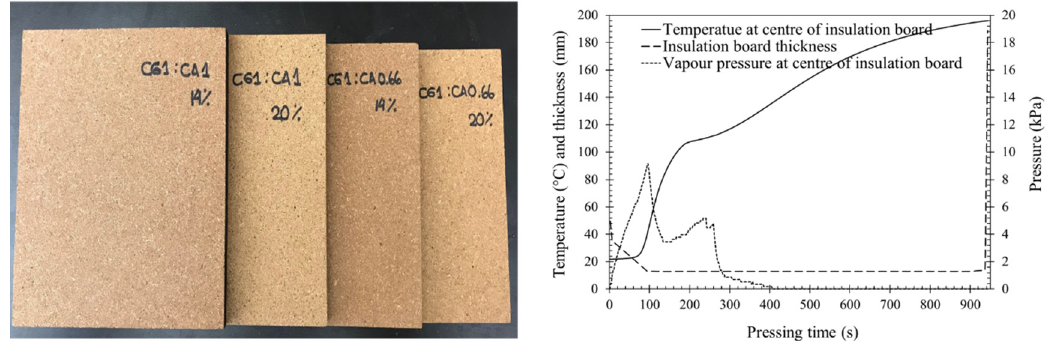
Figure 2. Wood fiber insulation boards and evolution of the temperature and vapor pressure at center of insulation board during pressing time.